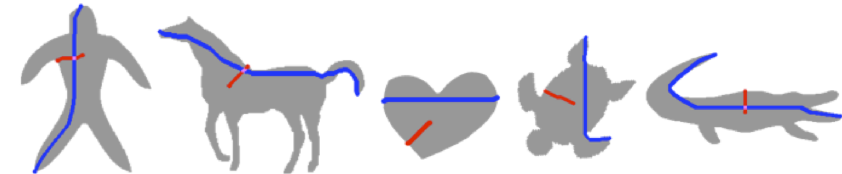
Figure 2. R and G correspond to the thickness of the shape body (red) and the maximum distance between the shape extremities (blue),